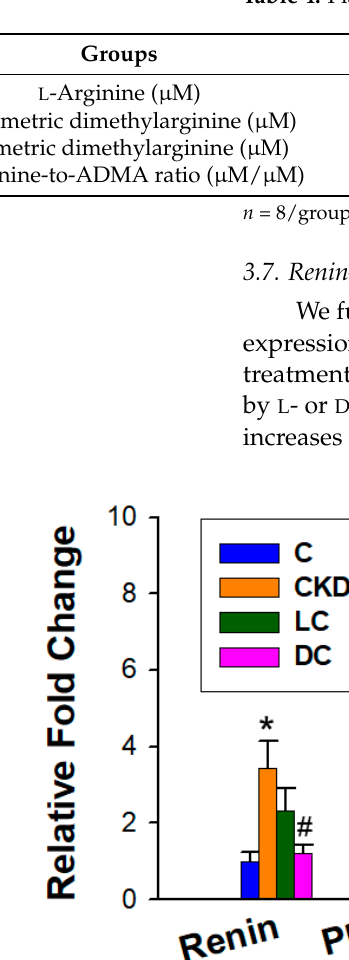
Table 4. Plasma NO parameters.